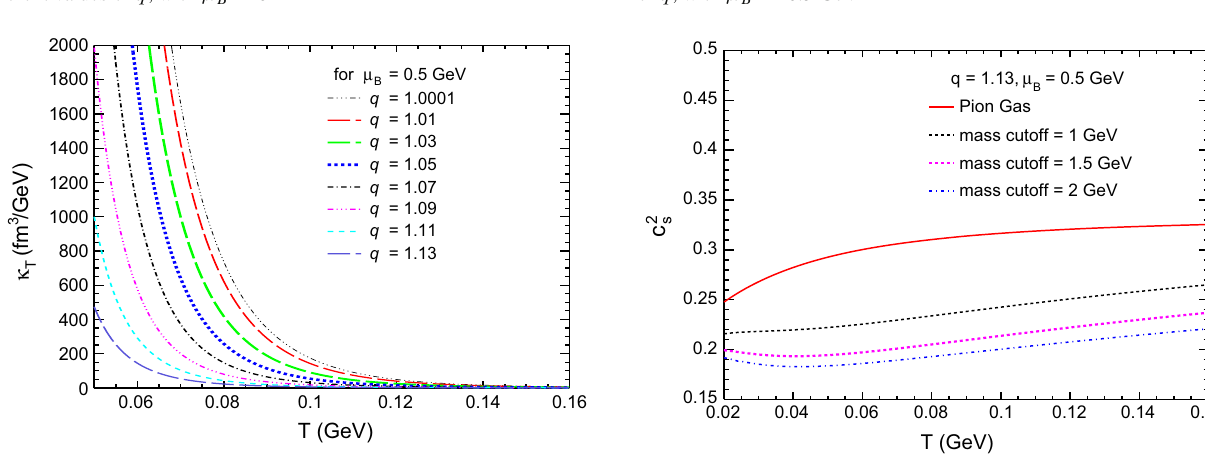
Fig. 6 Isothermal compressibility as a function of temperature for dif- ferent values of q , with μ B = 0